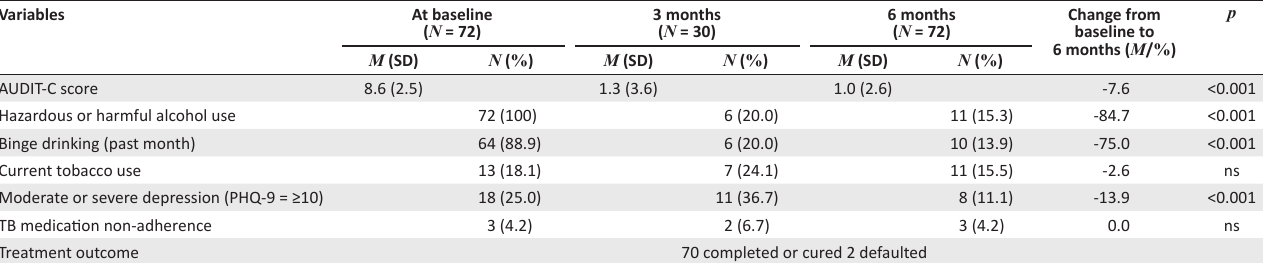
TABLE 2: Change in alcohol, tobacco use, depression and TB medication non-adherence over 6-month follow-up (N = 72).